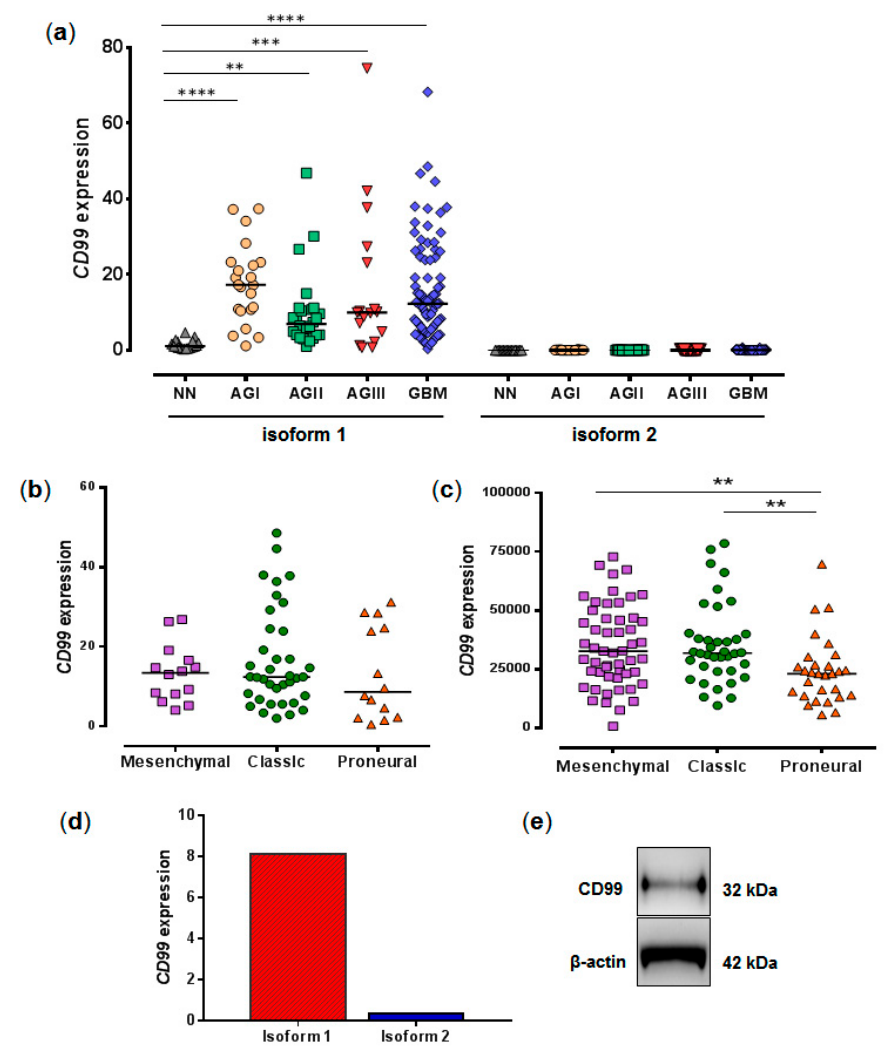
Figure 1. Expression of CD99 in astrocytomas of different malignant grades and the U87MG cell line. ( a ) Relative quantification of mRNA of CD99 isoforms 1 and 2 in 23 pilocytic astrocytoma (AGI), 26 low-grade astrocytoma (AGII), 17 anaplastic astrocytoma (AGIII), 84 glioblastoma (GBM), and 19 non-neoplastic (NN) tissue samples. The relative expression values were calculated, based on the geometric mean of the HPRT , BCRP , and GUSB housekeeping expression levels of each sample. The differences among the groups were significant ( p < 0.0001, Kruskal-Wallis test). The horizontal bar indicates the median of each group. Asterisks indicate statistical differences: ** p < 0.01, *** p < 0.001, **** p < 0.0001, Dunn’s test. ( b ) Isoform 1 CD99 expression levels of GBM molecular subtypes in the present series determined by qRT-PCR and ( c ) in TCGA database determined by RNA-Seq. Differences among groups were significant ( p = 0.0031, Kruskal-Wallis test) for TCGA cases (** p < 0.01 for proneural vs. classic and proneural vs. mesenchymal, Dunn’s test). The horizontal bar indicates the median of each group. ( d ) Relative quantification of mRNA for CD99 isoforms 1 and 2 in glioma cell line U87MG. HPRT was used as a reference gene. The results were expressed as the means of 2 independent experiments. ( e ) Representative western blot, showing the expression of CD99 in U87MG. β -actin was used as a control in the experiment. Only one band, corresponding to isoform 1 with 32 kDa, was observed.